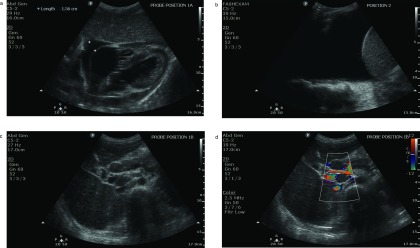
Images of Findings From Focused Assessment With Sonography of HIV-Associated Tuberculosis Protocol in Participants With Signs and Symptoms of Tuberculosis (a) Anechoic fluid surrounding the heart consistent with a moderate pericardial effusion. (b) Anechoic area superior (left) to the diaphragm and liver consistent with a large right pleural effusion. (c) Isoechoic nodules consistent with peri-portal and para-aortic lymphadenopathy. (d) Color Doppler further differentiates vasculature from lymph nodes.© 2016 Daniel Kahn/UCLA